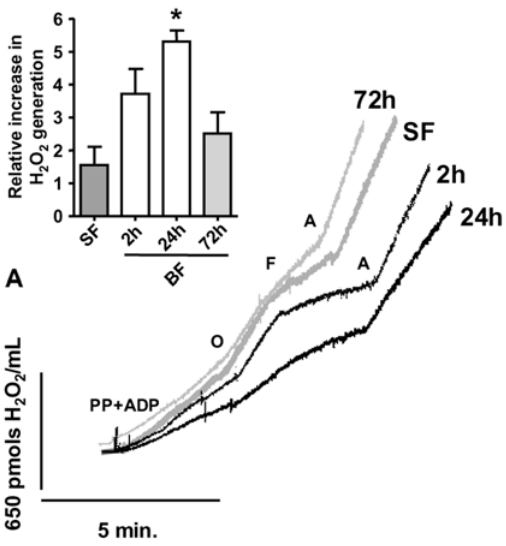
Figure 3. Blood feeding induces a time-dependent reversible inhibition of mitochondrial H 2 O 2 generation. Representative traces of H 2 O 2 formation from sugar fed (SF, thick gray line) and three different times ABM (2 h, 24 h and 72 h) of A. aegypti FM mitochondria using 10 mM of the substrates pyruvate-proline. Additions were 10 mM pyruvate-proline and 1 mM ADP (PP + ADP). The non-phosphorylating state 4-like respiration was induced by the addition of 4 m g/mL oligomycin (O). Uncoupled respiration was measured after the addition of up to 5 m M FCCP (F). To assess the maximum H 2 O 2 generation rate, 4 m g/mL of antimycin a (A) was added after FCCP. The inset . The